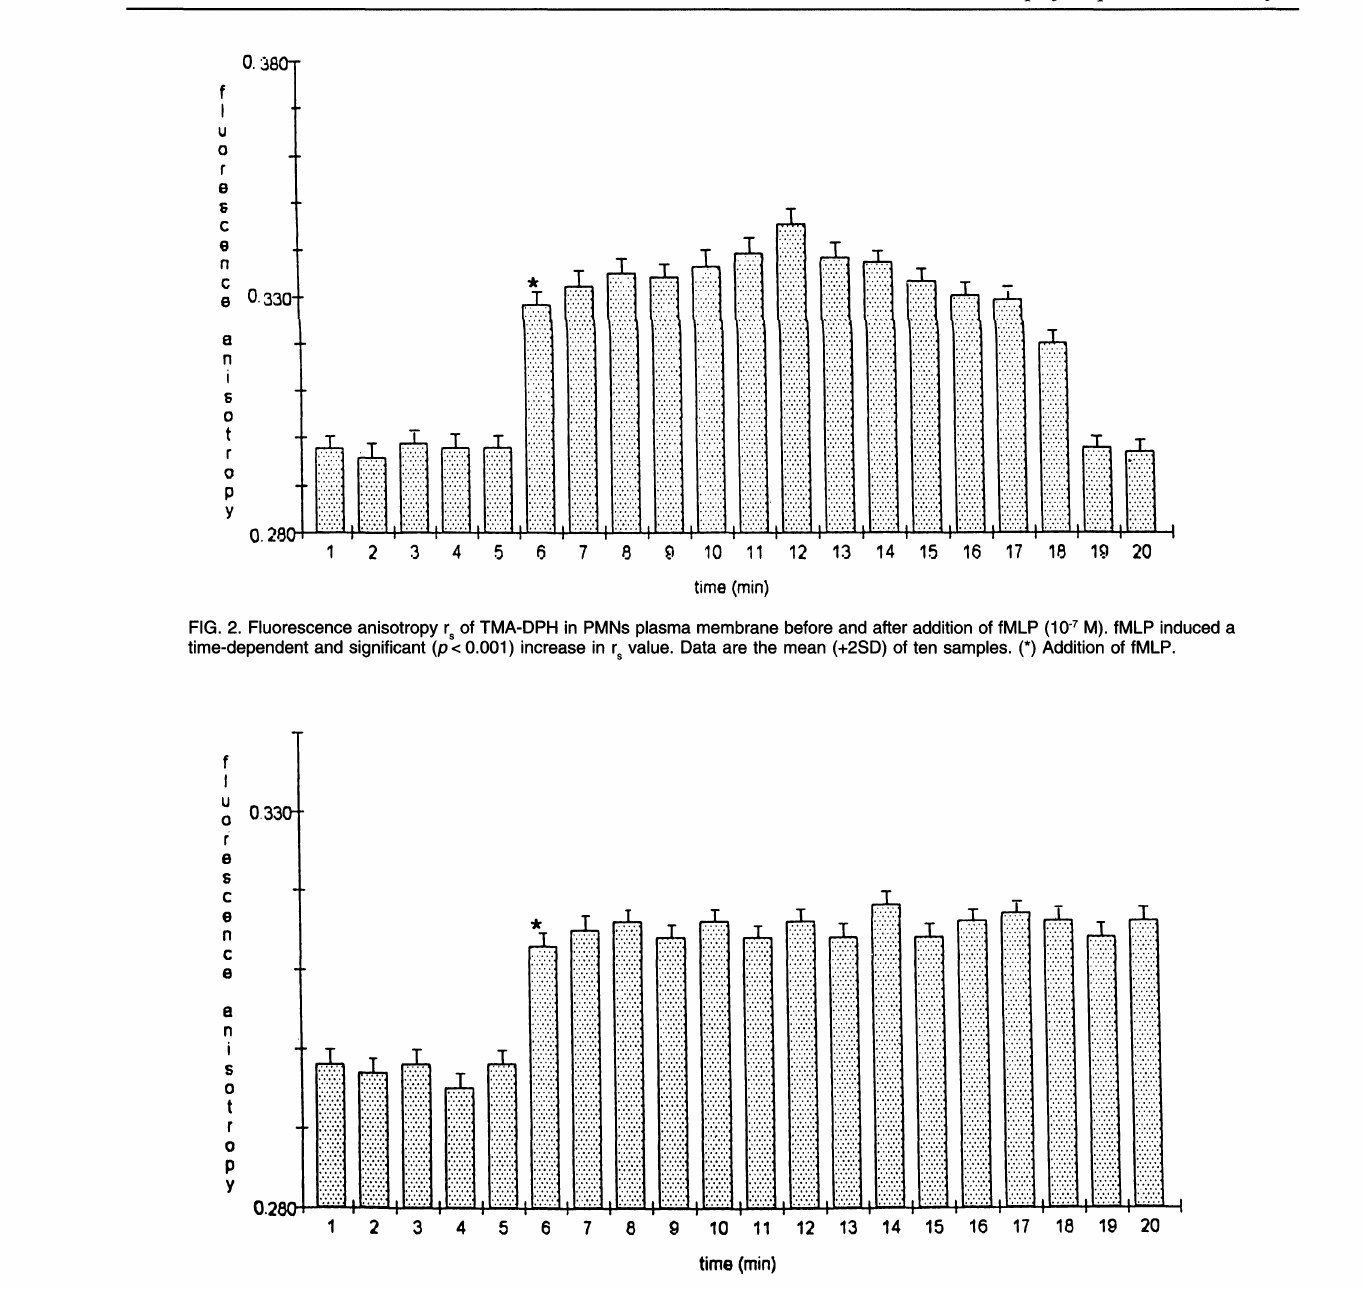
FIG. 3. Fluorescence anisotropy rs of TMA-DPH in PMNs plasma membrane before and after addition of nedocromil sodium (300 pM). Nedocromil induced a stable and significant (p < 0.001) increase in r, value. Data are the mean (+2SD) of ten samples. (*) Addition of